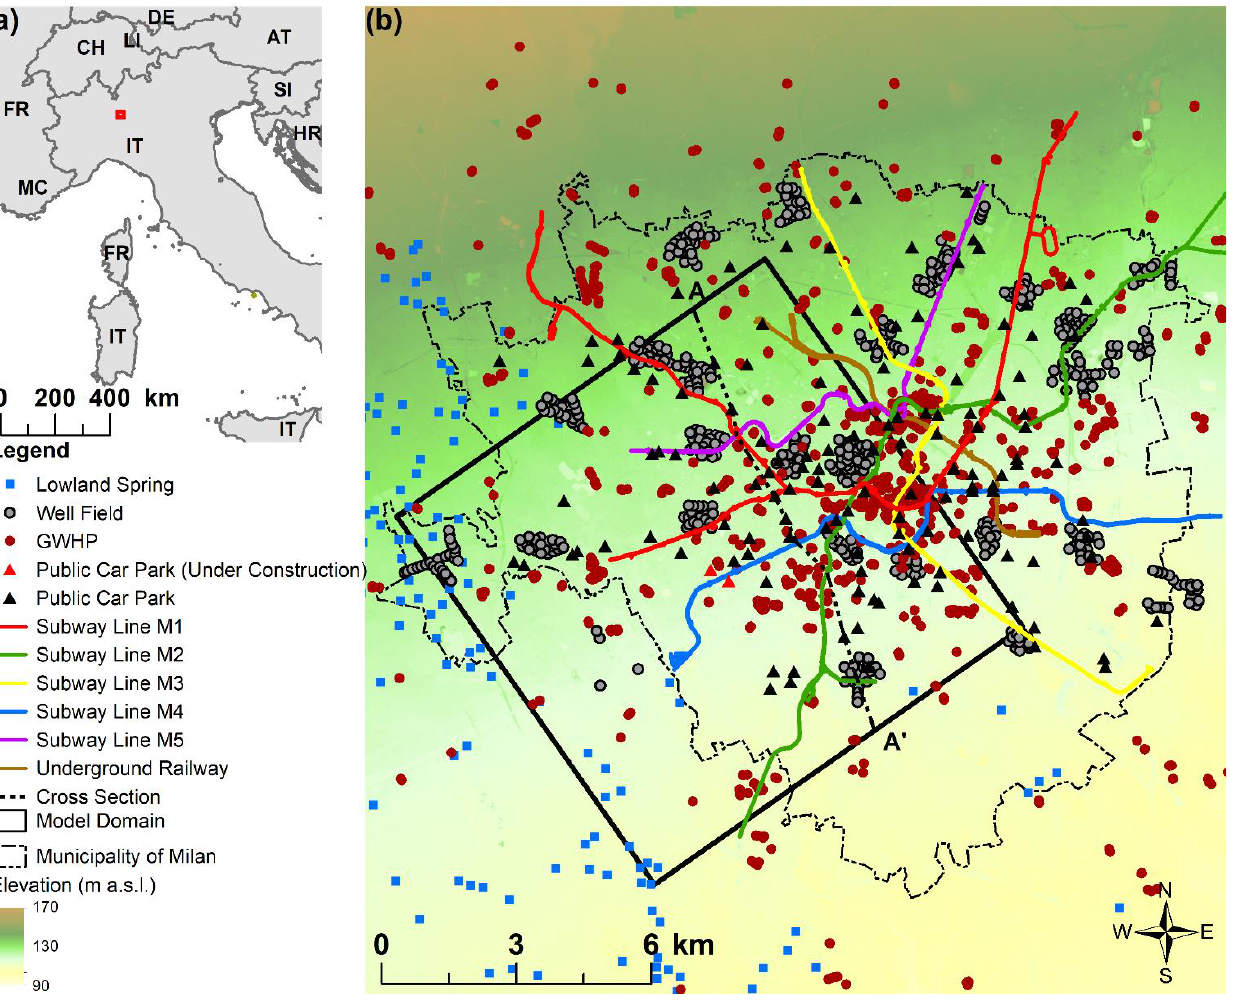
Figure 1. ( a ) Geographical setting of the study area; ( b ) main hydrogeologic features (lowland springs) Color coding for the subway lines respects the color coding used by the subway managing company. Public car parks have been represented as triangles to differentiate them from wells. (Image readapted from Sartirana et al.